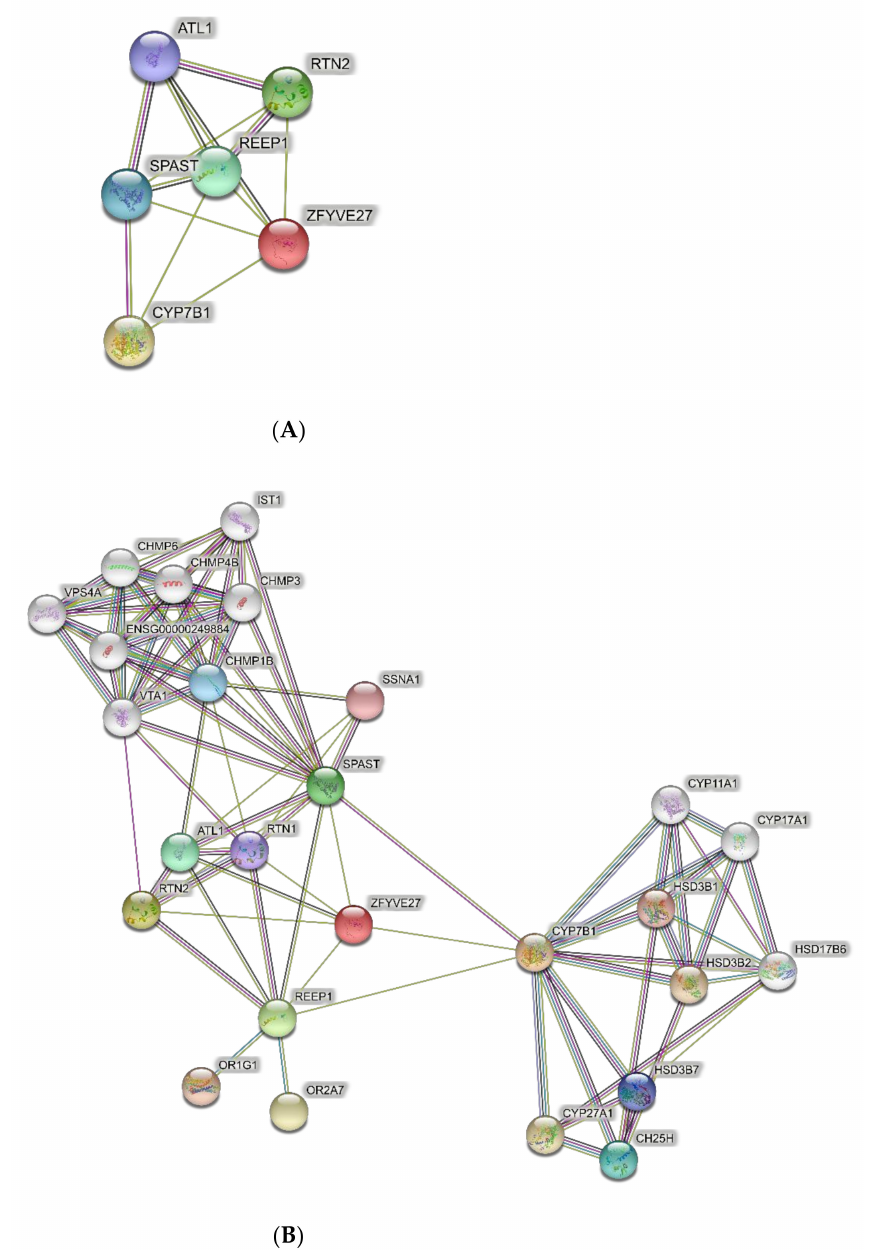
Figure 1. Predicted protein–protein interactions (PPI) networks for the six genes of the most common SPGs. ( A ) Direct interactions. ( B ) Second shell